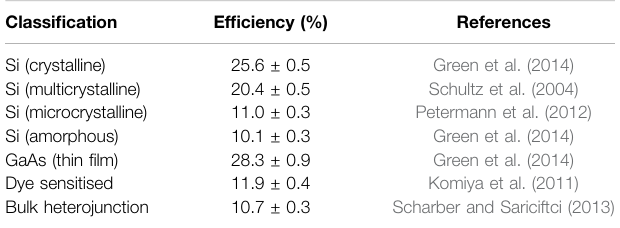
FIGURE 8 | (A) General molecular structure of naphthyl diimides (NDIs); (B) framework structure of a free-base porphyrin presenting meso -position and β -position, which may be functionalised. Additionally, the N H ’ s are available for deprotonation and subsequent